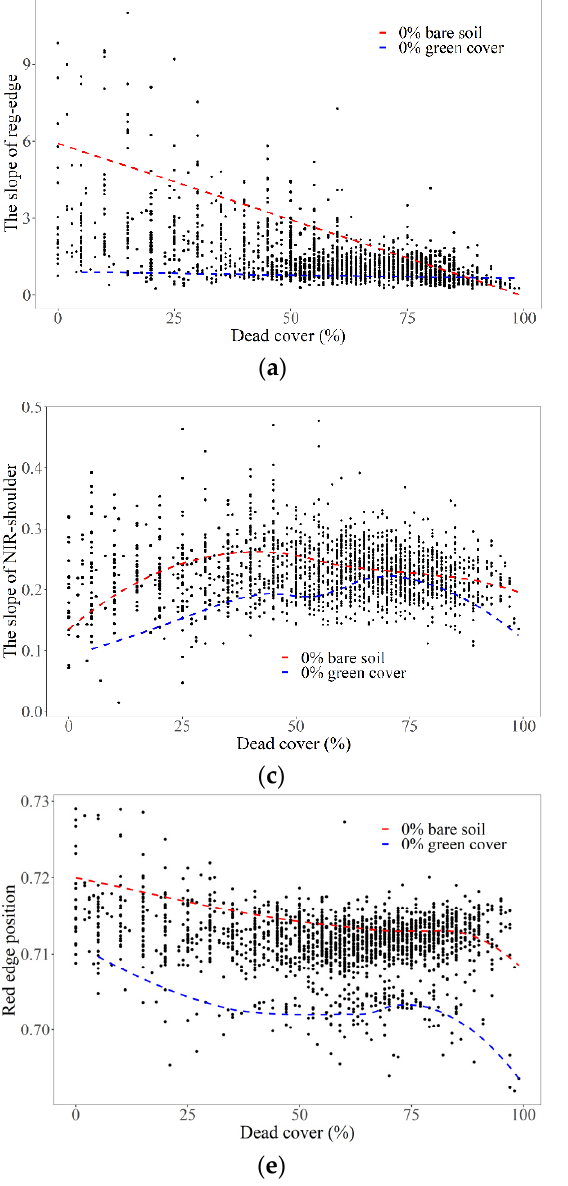
Figure A1. The relationship between dead cover and the spectral parameters. The relation between dead cover and the slope of red-edge ( a ), yellow-edge ( b ), NIR shoulder ( c ), NDVI using red valley ( d ), red-edge position ( e ) and red valley position ( f ) extracted from field measured hyper-spectra. Table A1. Correlation matrix between LAI and different spectral metrics.